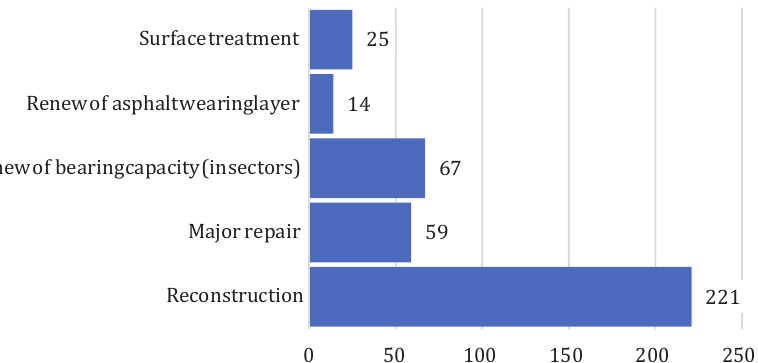
Figure 2. The number of repaired objects in each road work